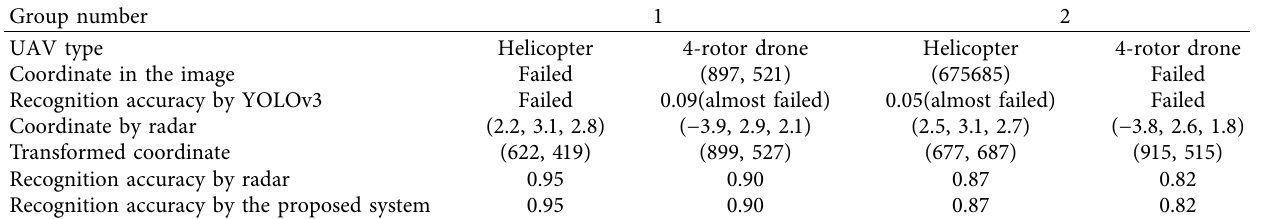
Table 2: Experiment 1: identification of UAVs by the information fusion model in a poor light and short distance scenario.